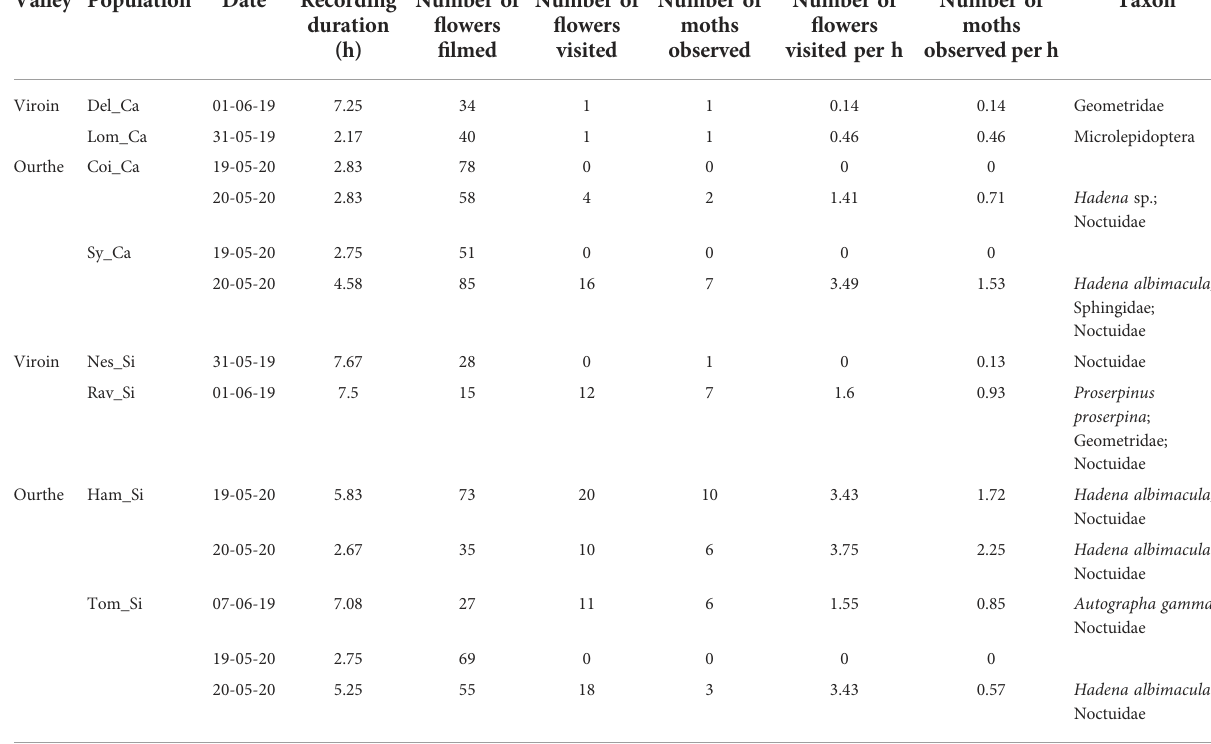
TABLE 3 Results of infrared cameras fi lming nocturnal pollinators in eight calcicolous (Ca) and silicicolous (Si) populations of Silene nutans from the Viroin Valley in 2019 and the Ourthe Valley in 2019 and 2020. Valley